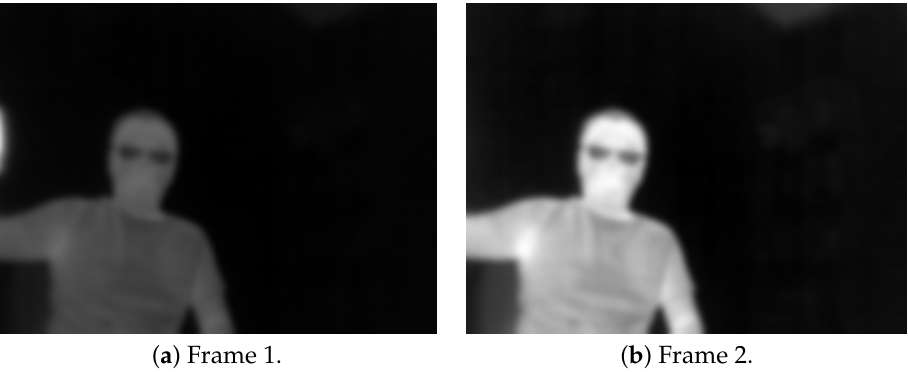
Figure 1. AGC changes the contrast in the images when a hot cup exits a scene: